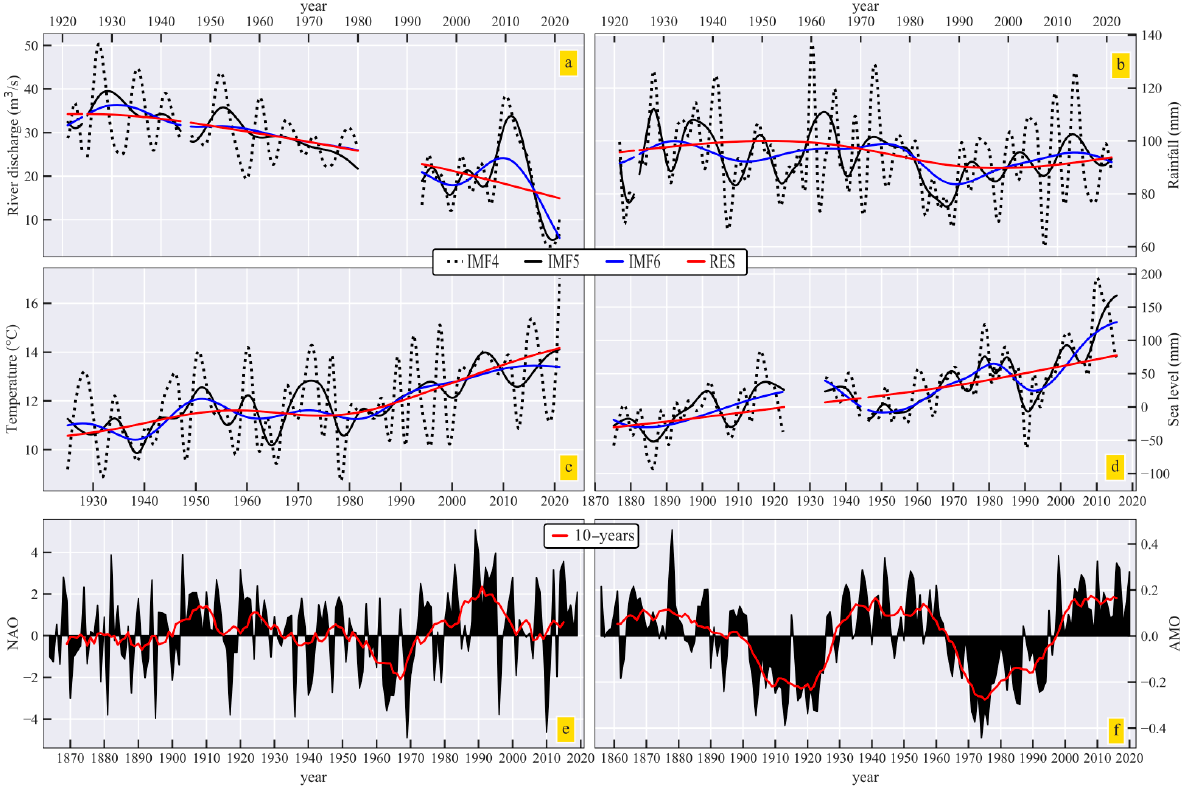
Figure 5 . The IMFs and RES curves for river discharge ( a ), rainfall ( b ), temperature ( c ) and sea level ( d ), from the EMD analysis; the winter NAO ( e ) and AMO ( f ) indices time series, with a 10-year filter. Table 1. Datasets considered in this study and related residual